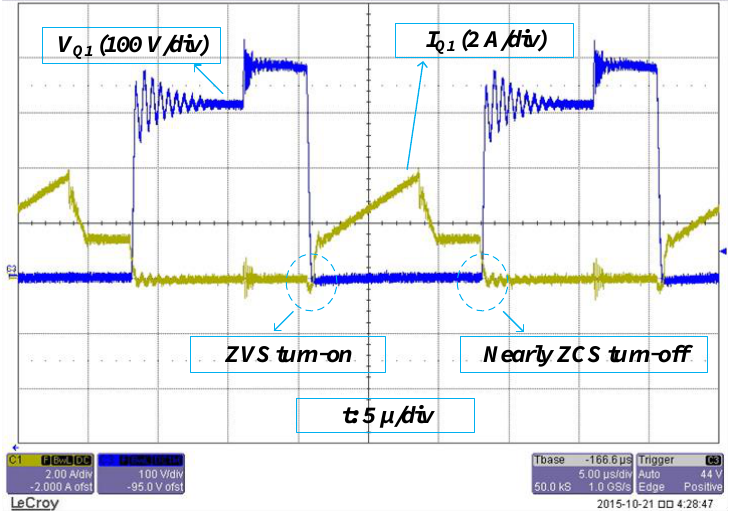
Figure 10. Voltage and current of switch Q 1 at 100% of load.